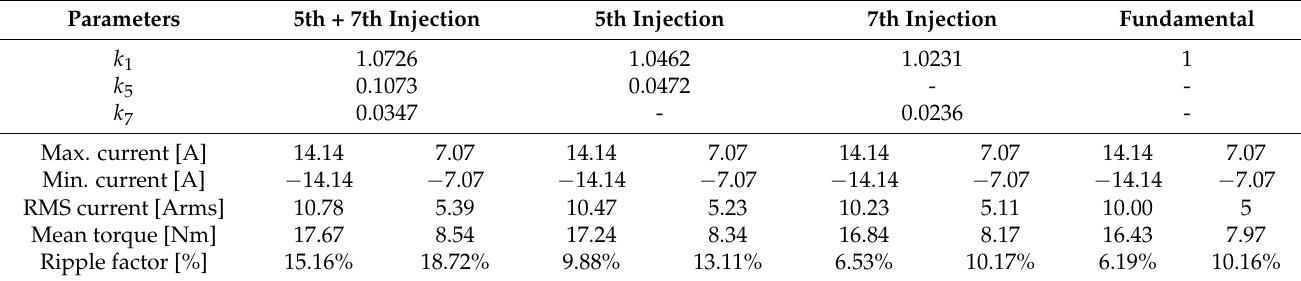
Table 3. FEM simulation results for phase stator current and output torque according to harmonic injection